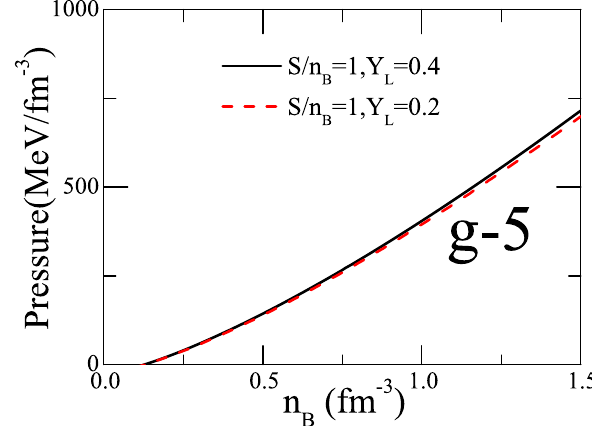
Fig. 8 The isospin asymmetry of the star matter as a function of the baryon density in the three snapshots along the PQS evolution for g-4 and g-5